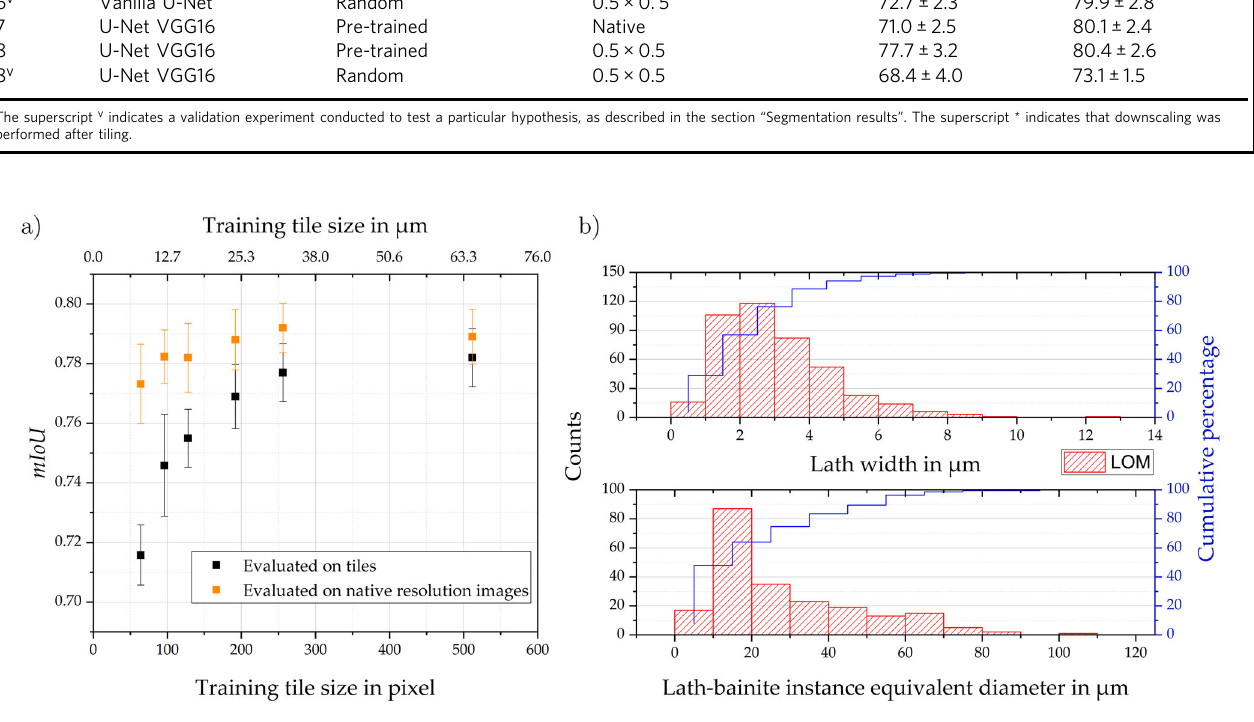
In Table 1 the LOM image-trained models along with model initialization type, image resizing factor, and IoU metrics are listed.